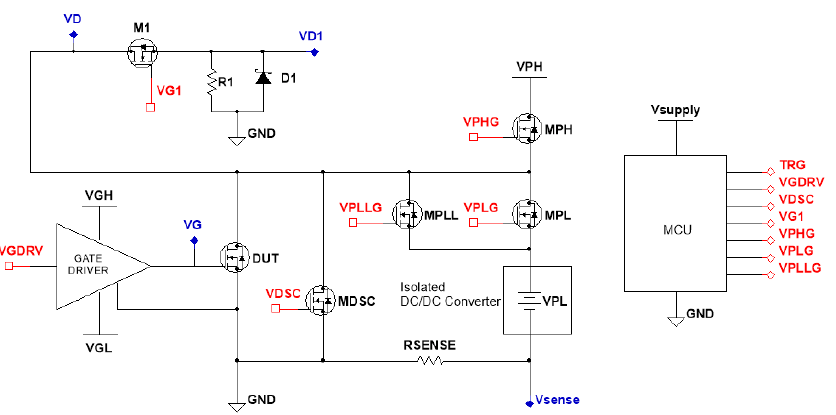
Figure 1. Setup schematic. The whole setup is controlled by an MCU used for triggering the DSO acquisition with logarithmic time steps and generating the necessary synchronization signals.